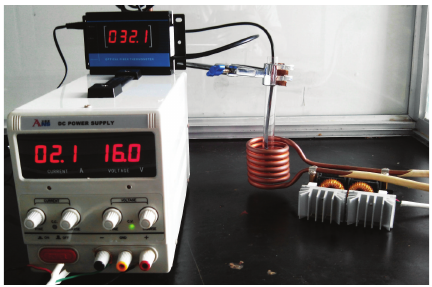
Figure 1: Homemade device for measuring induction heating